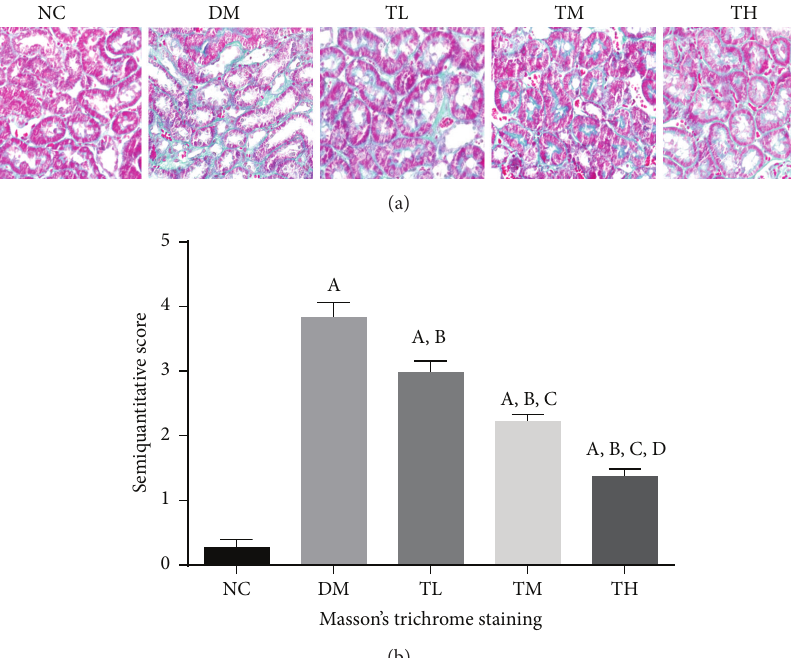
Figure 1: Pathomorphology of renal tissue in rats to evaluate tubulointerstitial fibrosis (Masson × 400). (a) Representative Masson’s trichrome stained sections. (b) Semiquantitative score of tubulointerstitial fibrosis for different groups. NC: normal control; DM: diabetic rats without drug treatment; TL: low-dose TGT (1mg/kg/day); TM: medium-dose TGT (3 mg/kg/day); TH: high-dose TGT (6mg/kg/day). A 𝑝 < 0.05 versus NC group, B 𝑝 < 0.05 versus DM group, C 𝑝 < 0.05 versus TL group, and D 𝑝 < 0.05 versus TM